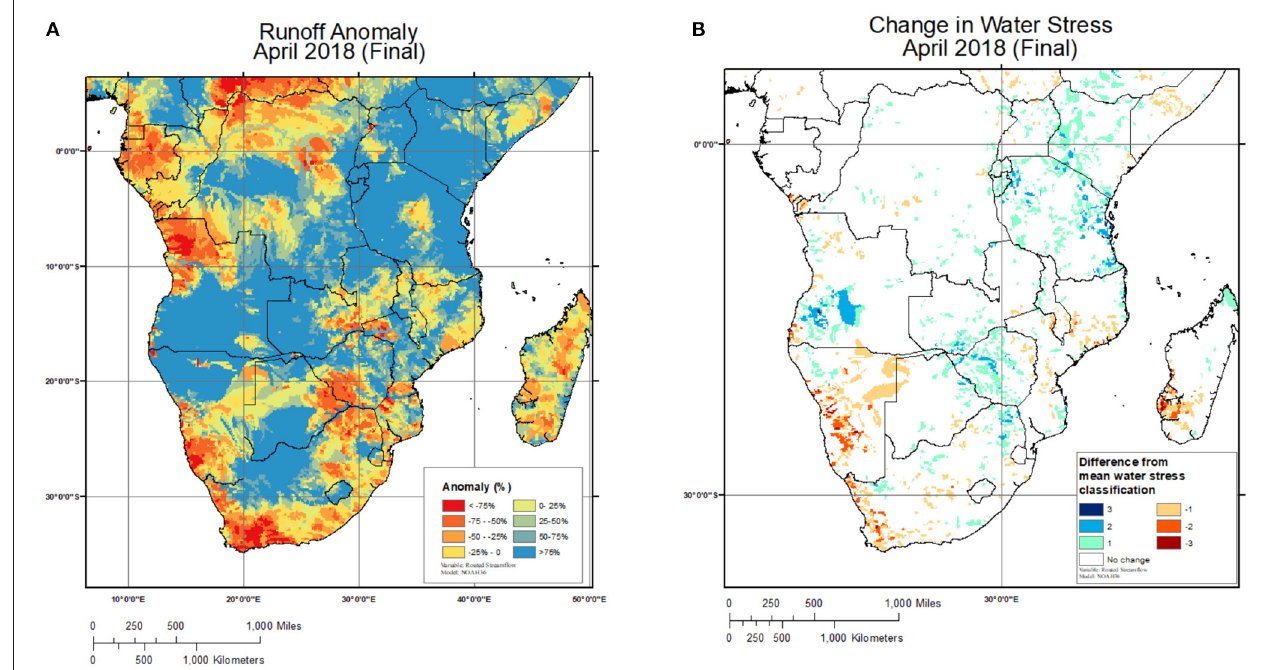
FIGURE 4 | (A) Streamflow anomalies show surplus for much of the region, and 0–75% basin average streamflow deficits for April 2018 in Southern Madagascar. (B) Water Stress Change, based on annual Falkenmark classifications show that Southern Madagascar (and Western Cape) is 1–3 classes more stressed than a typical April. Maps updated twice a month at